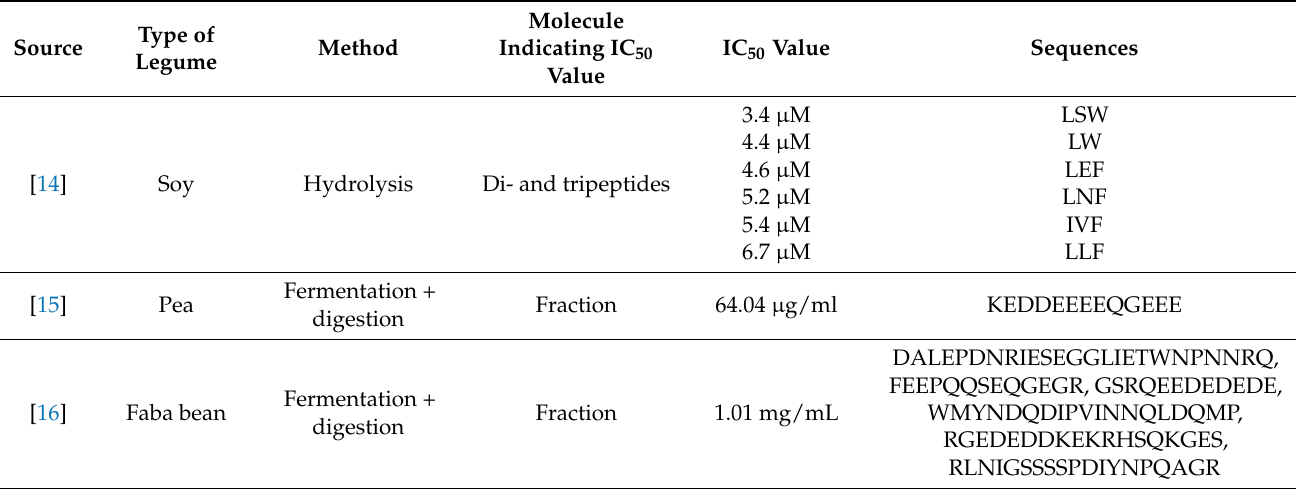
Table 1. IC 50 values and bioactive peptide sequences of investigated legumes against ACE